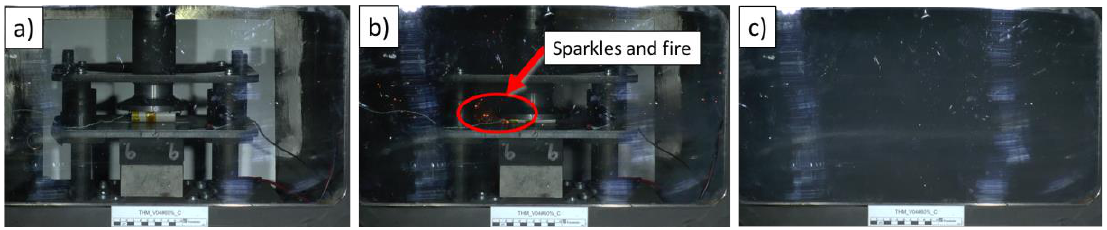
Figure 7. Experiment: Flat compression with v = 10 mms −1 of cell with SoC of 60%. ( a ) first contact between flat impactor and batteries. ( b ) maximum intrusion and ( c ) end of test, impactor is moving upward.